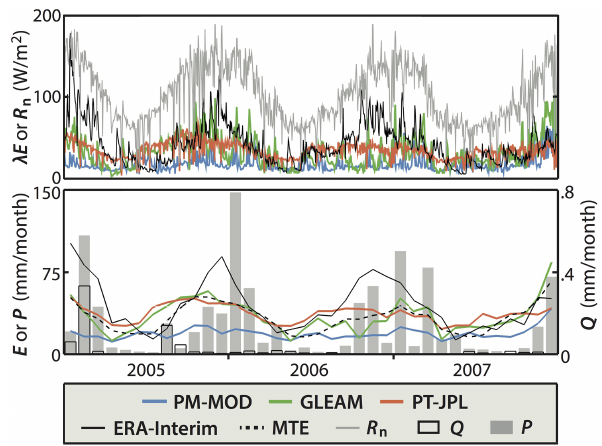
Figure 9. Evaporation during the Australian Millennium Drought. Top panel: daily time series of surface net radiation (SRB 3.1) and latent heat flux from the three WACMOS-ET products for the Dar- ling Basin during 2005–2007. ERA-Interim latent heat flux is also illustrated for comparison. Bottom panel: monthly time series of evaporation, precipitation (GPCC v6 with gauge correction factors from Fuchs et al., 2001), and discharge (GRDC). The contributing area is shown in Fig.